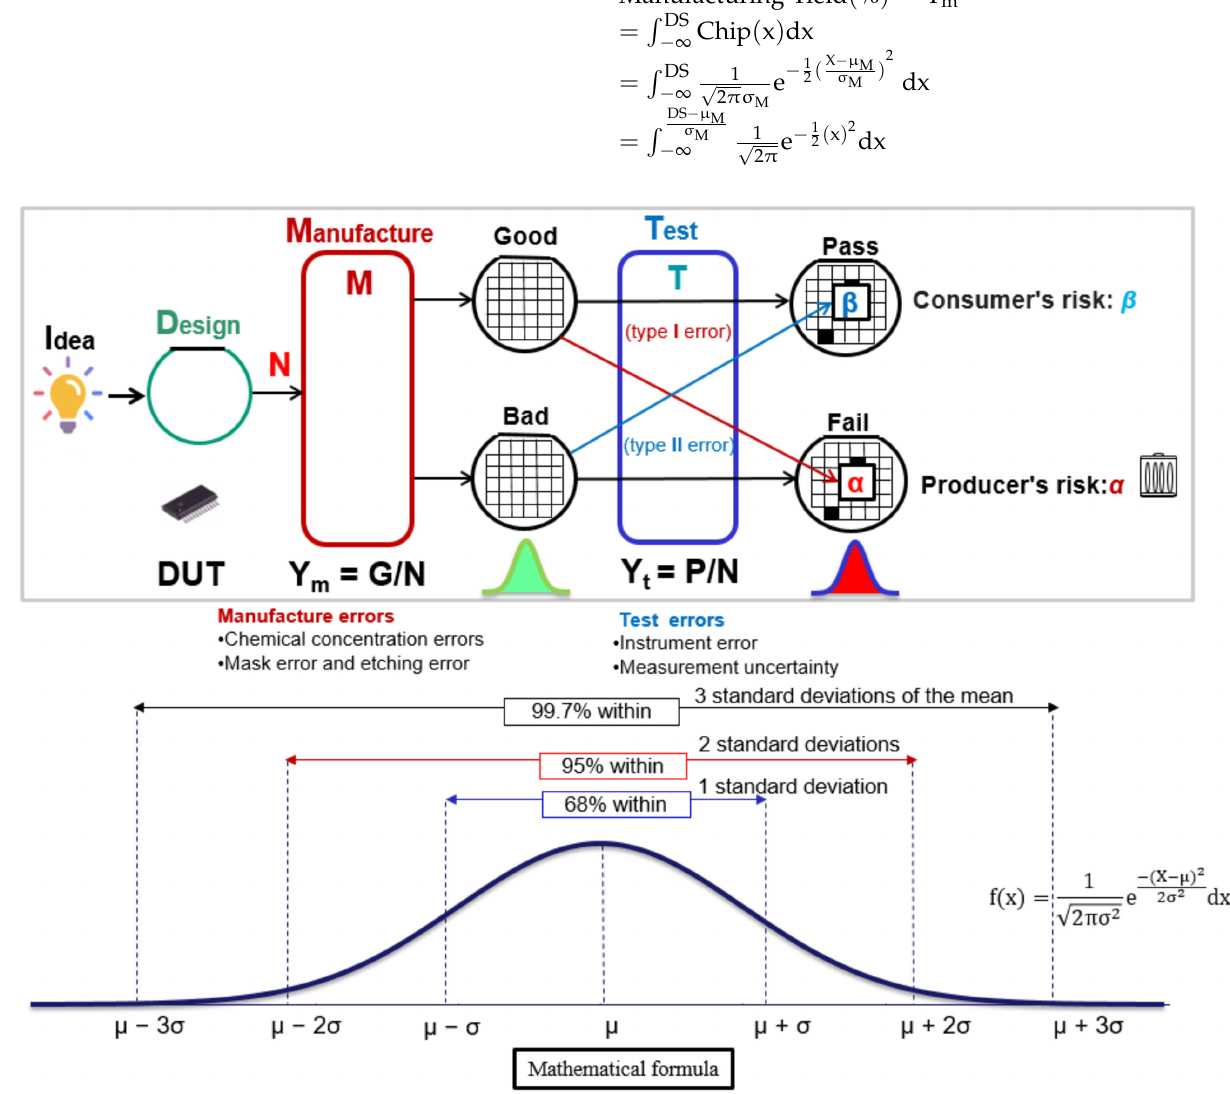
Figure 1. The process of chip fabrication and testing. Assume the DS is 0.858 GHz (DS = 1165 ps), the average of the normal distribution µ σ M = 1000 ps (picosecond), and the standard deviation M = 100 ps for a circuit. Figure 2 depicts the chip delay time distribution X ~ N (x; µ M = 1000 ps and σ M = 100 ps). The horizontal axis is the time parameter of the circuit characteristics, and the vertical axis is the probability density of the time parameter. The chips manufactured by the foundry are classified according to the DS, and they can be divided into good products (Good) that meet the design specifications and bad products (Bad) that do not meet the design specifications. Manufacturing yield (true yield) can be derived as Y m = P[Good] = P[X < DS] = 95% using the formula